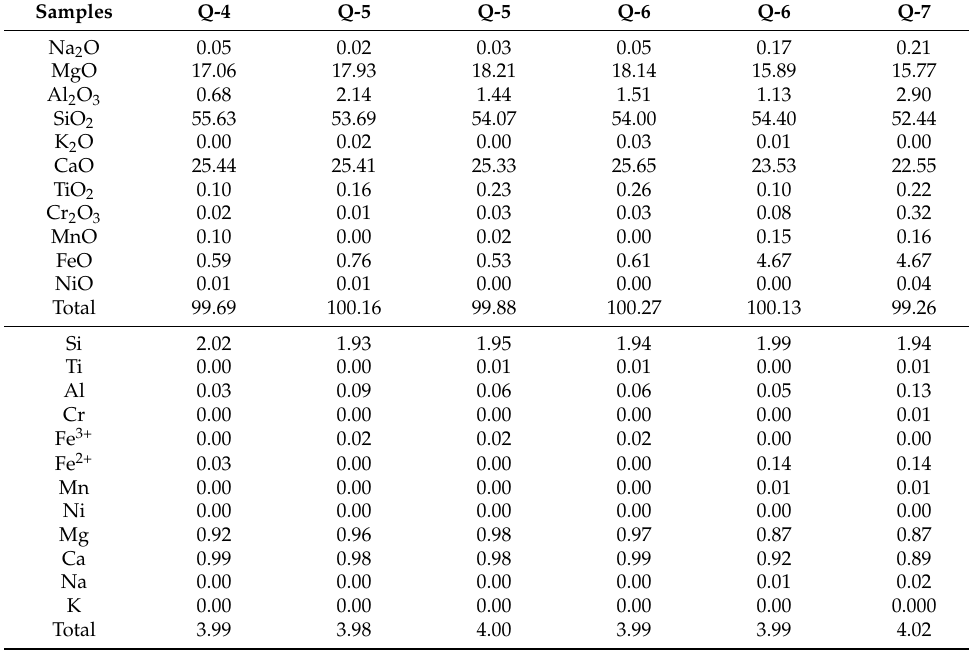
Table 4. Chemical compositions of the diopside